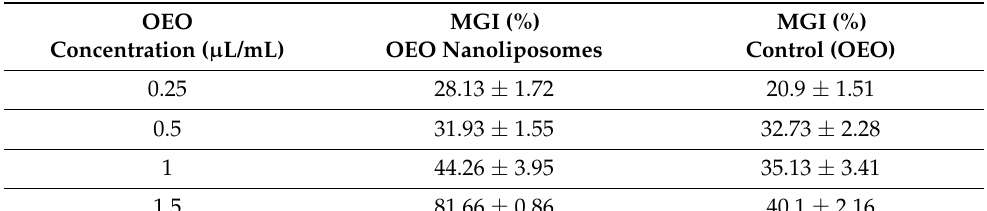
Table 4. Mycelial growth inhibition (MGI) of OEO nanoliposomes. Pure OEO was taken as a positive control and empty nanoliposomes were taken as a negative control. Data are expressed as mean values ± standard deviation.